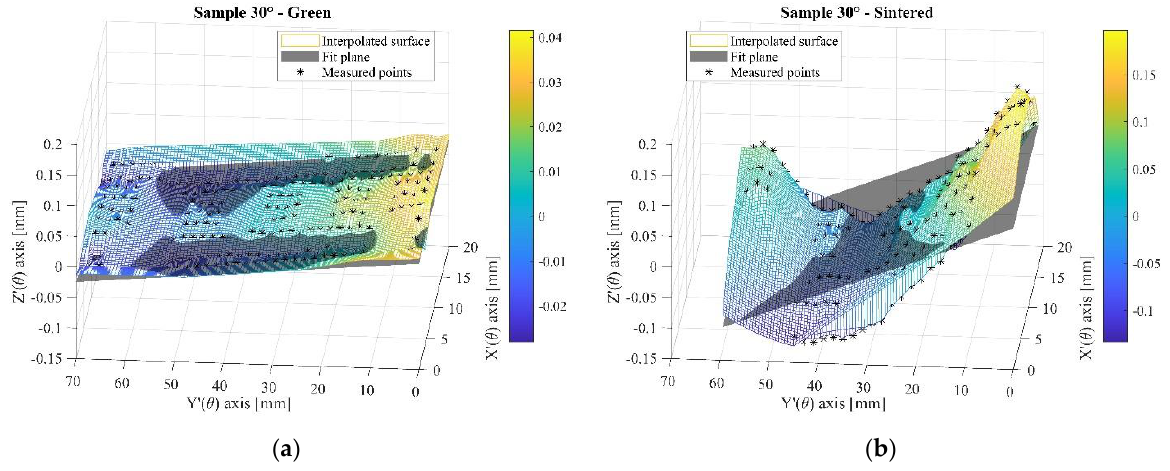
Figure 14. Sample 30° ( a ) points measured at the green state and reconstruction of the plane; ( b ) points measured at the sintered state and reconstruction of the plane.